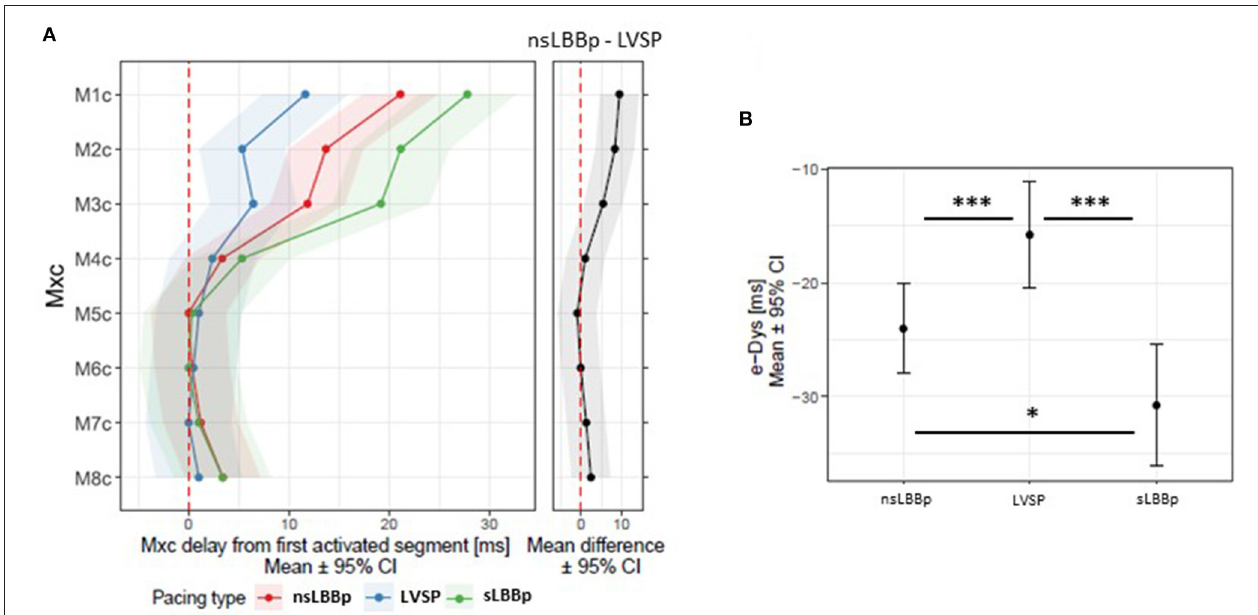
FIGURE 3 | (A) Local activation times M1c − 8c (first activated segment was placed at 0ms) and a comparison of e-DYS between nsLBBp, LVSP, and sLBBp (B) . * p < 0.05; *** p < 0.001.